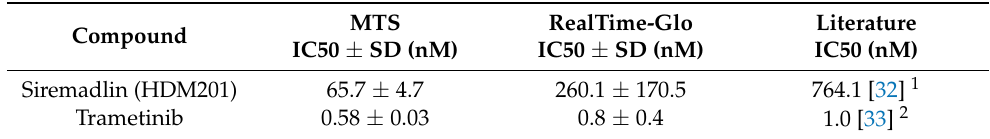
Table 3. Comparison of observed Siremadlin and Trametinib IC50 with data from the literature in